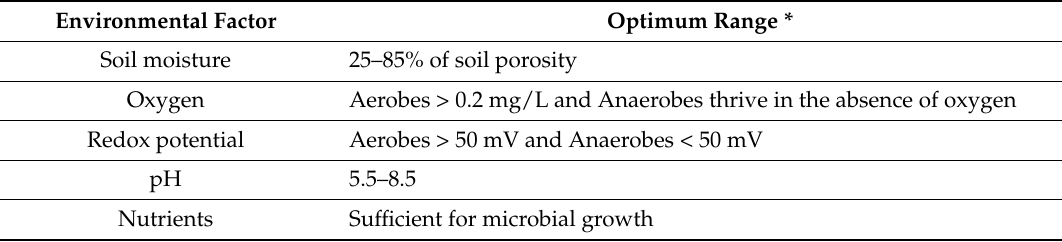
Table 1. Optimum levels of some important environmental factors for in-situ bioremediation of contaminated unsaturated subsurface soils (table amended from [6]).